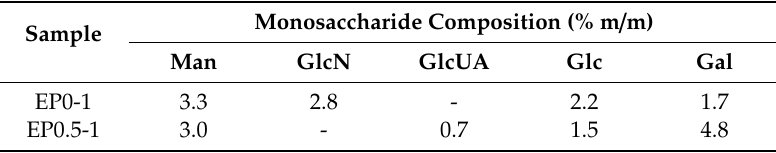
Table 1. Monosaccharide composition of EP0-1 and EP0.5-1.